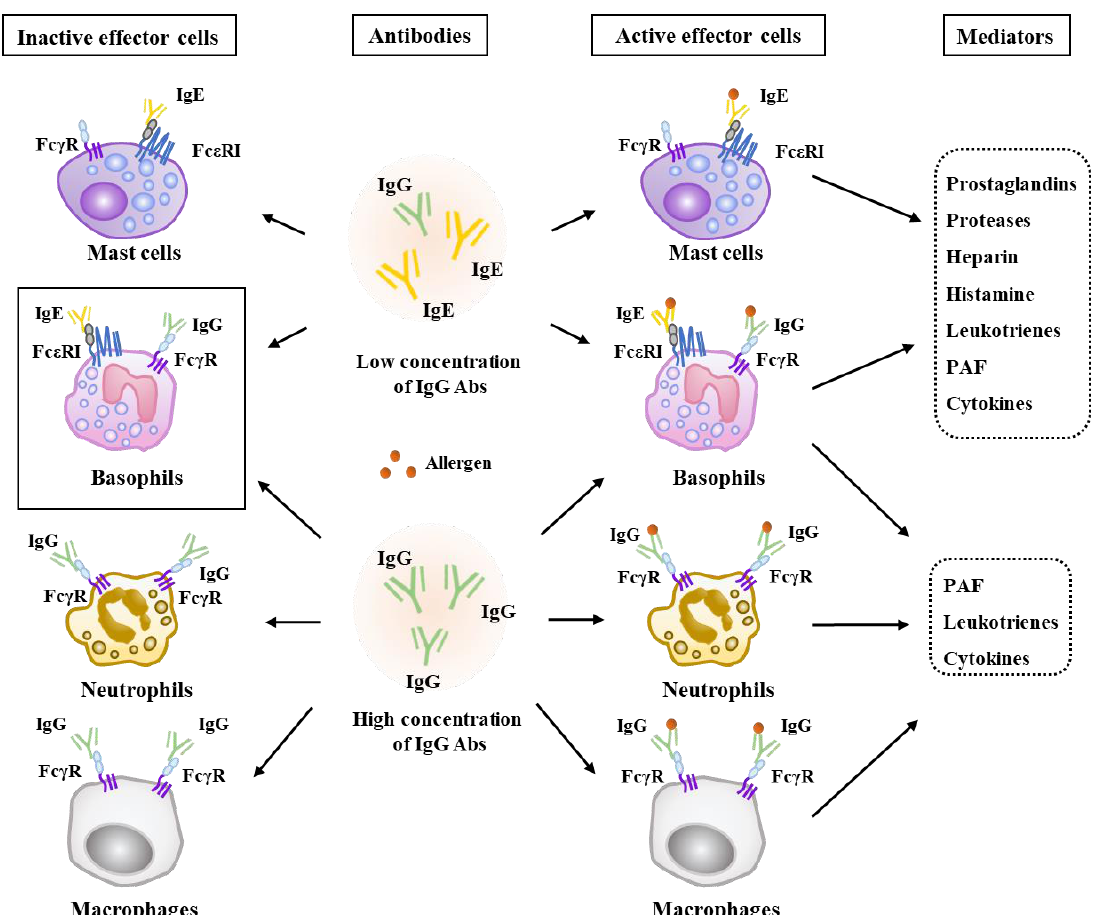
Figure 1. The mechanisms of antibody-mediated anaphylaxis. Allergen-specific Immunoglobulin E (IgE) antibodies and FcεRI -bearing effector cells play critical roles in anaphylaxis induced when concentrations of Immunoglobulin G (IgG) antibodies are low. Mast cells and basophils mediate IgE-mediated anaphylaxis. IgE-mediated anaphylaxis involves effector molecules including prostaglandins, histamine, leukotrienes, PAF, heparin, various cytokines and enzymes. The → arrows denote positive regulation. Anaphylatoxins such as C3a, C4a and C5a can also mediate anaphylaxis. Intradermal injection of C3a or C5a induces IgE-dependent mast cell degranulation and allergic skin inflammation